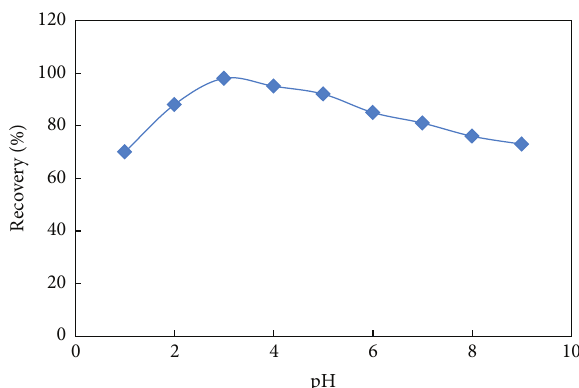
F 3: Effect of pH of sample solution on percent recovery of Au(III) by 9-acridinylamine alumina.